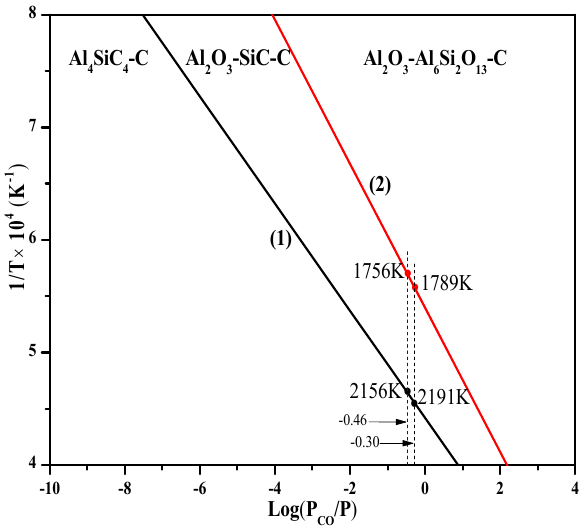
Figure 7. Stability region of solidification phase of Al 4 SiC 4 oxidized under different conditions.